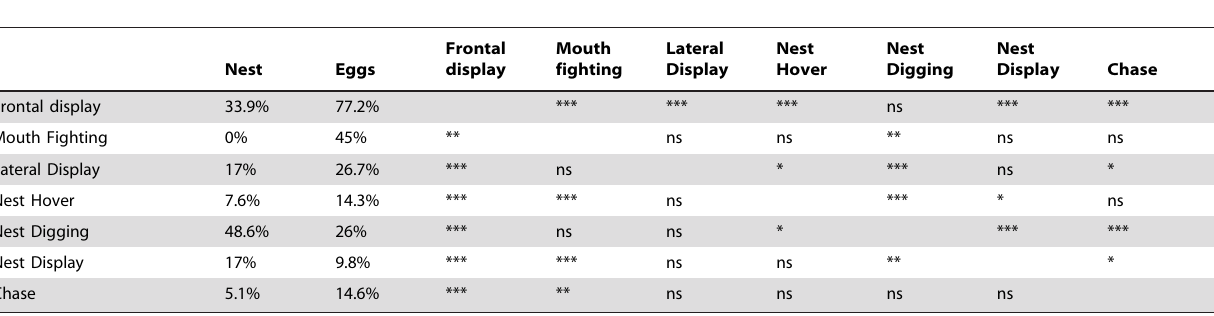
Table 10. Proportions of behavioural patterns exhibited in association with sounds in two contexts: Nest =Territorial female (above the diagonal); Eggs=Female incubating eggs (under the diagonal).